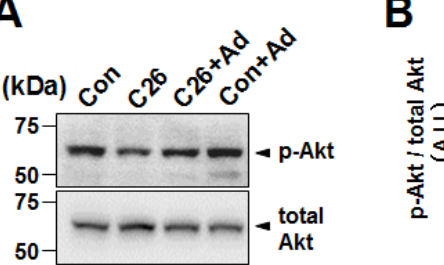
Figure 7. Effects of adiponectin treatment on the protein synthesis pathways in the in vitro cancer cachexia model. C2C12 myotubes were treated with C26 derived conditioned medium (C26-CM) or 1 µg/mL adiponectin, as indicated in Figure 6. Total proteins were analyzed by western blotting using antibodies for phospho-Akt and pan-Akt ( A ), phospho-mTOR and pan-mTOR ( C ), and phos- pho- and pan-p70S6 kinase (S6K) ( E ). A representative result from one of three independent exper- iments is shown. Densitometric analyses of western blotting shown in ( A , C , E ) are presented in ( B , D , F ) respectively. The bar graphs indicate the mean relative expression ± SD. Statistical analysis was performed by Kruskal-Wallis analysis followed by Mann-Whitney U tests. *: p < 0.05. Figure 8. Effects of adiponectin treatment on LC3 expression. C2C12 myotubes were treated with C26-CM or adiponectin, and total proteins were analyzed by western blotting with anti-LC3 ( A ). Representative results from one of three independent experiments are shown. ( B ) Densitometric analyses of western blotting shown in ( A ) are presented in ( B ). The bar graphs indicate the mean LC3-II expression normalized by total LC3 (LC3-I+II) ± SD. Statistical analysis was performed by Kruskal-Wallis analysis followed by Mann-Whitney U tests. *: p < 0.05.